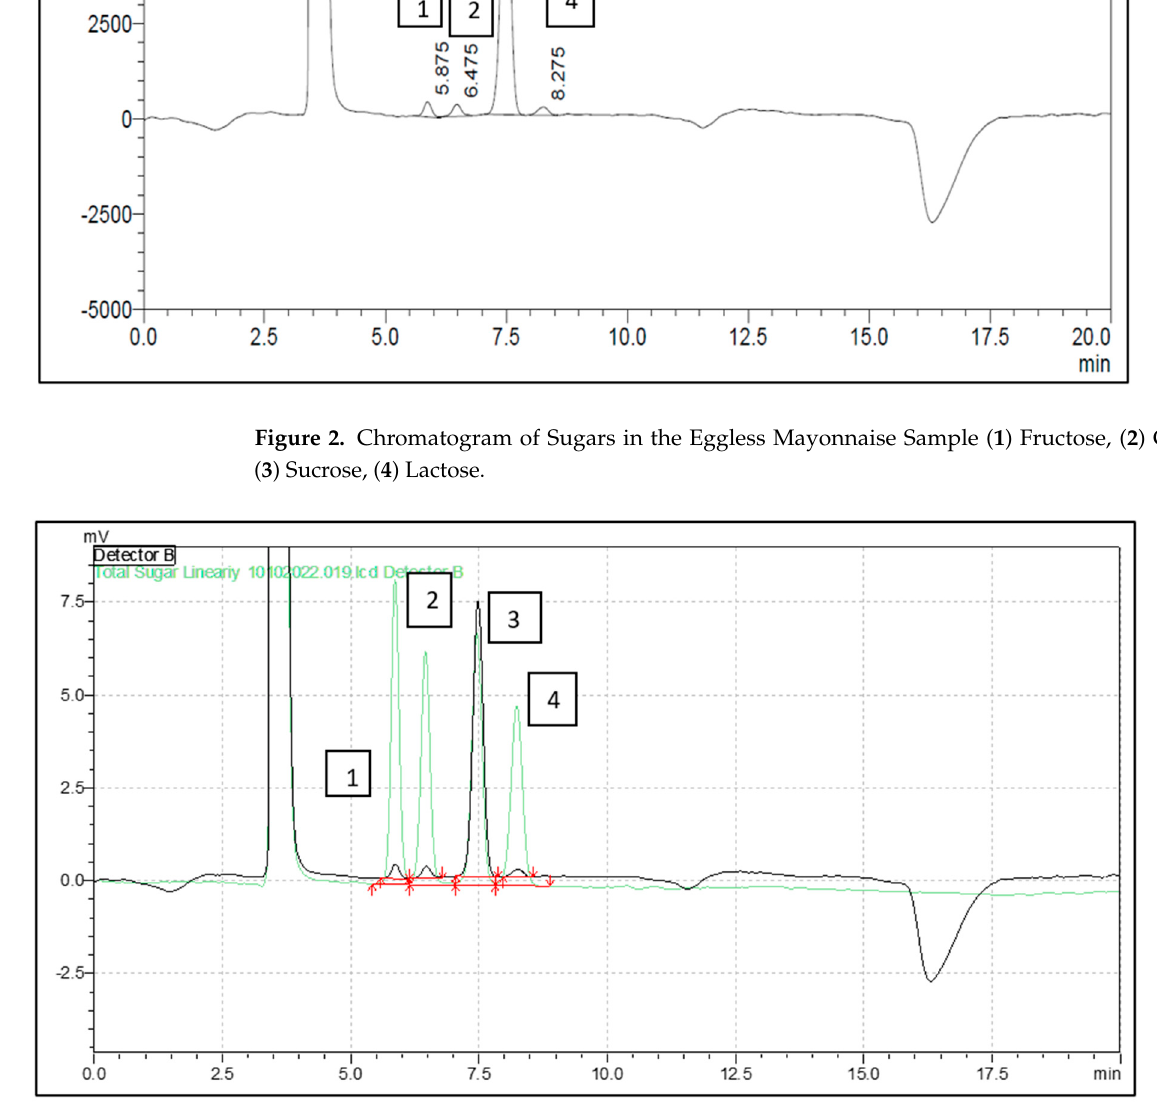
Figure 3. Overlay Chromatogram of Sugars in Eggless Mayonnaise Sample: ( 1 ) Fructose, ( 2 ) Glucose, ( 3 ) Sucrose, ( 4 ) Lactose, and standard sugars (green color chromatogram − standard sugars; Black color chromatogram − sugars in eggless mayonnaise sample).